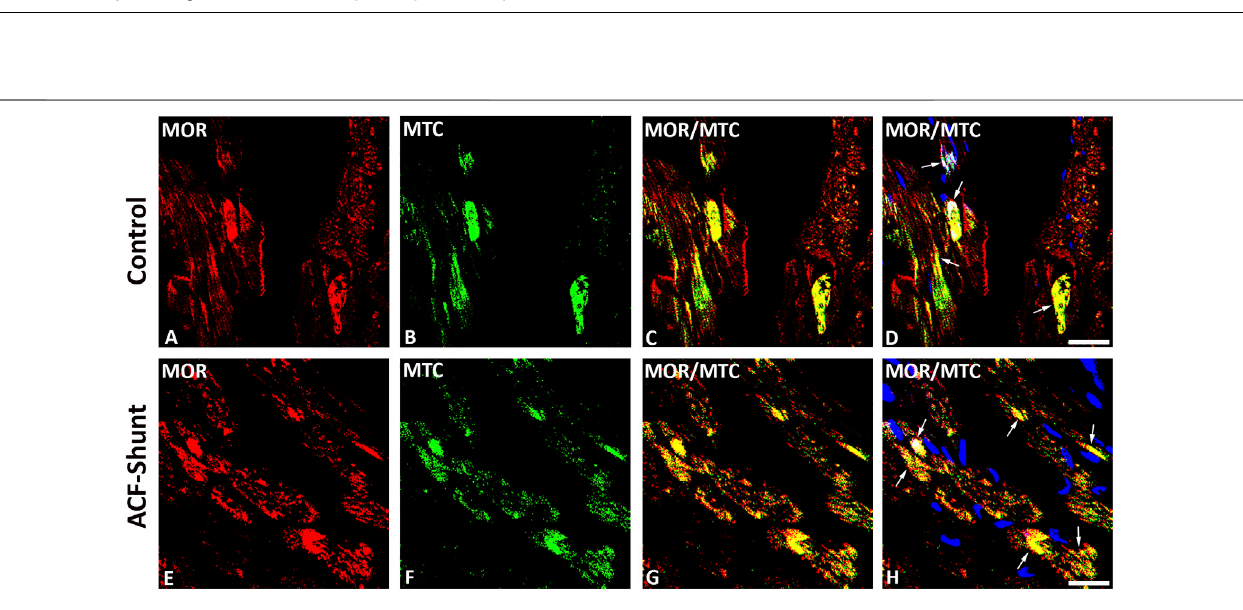
Frontiers in Pharmacology |